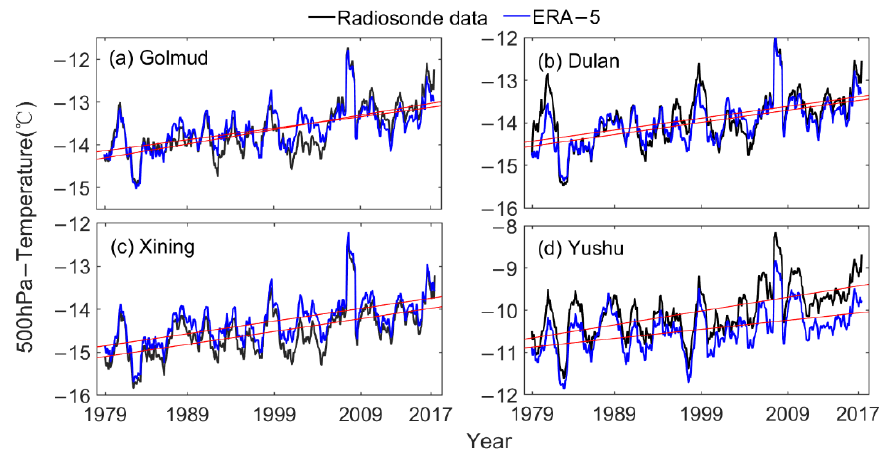
Figure A4. Trends of the monthly moving average of relative humidity for radiosonde and ERA-5 data at 500 hPa. ( a ) Golmud station, ( b ) Dulan station, ( c ) Xining station, ( d ) Yushu station.